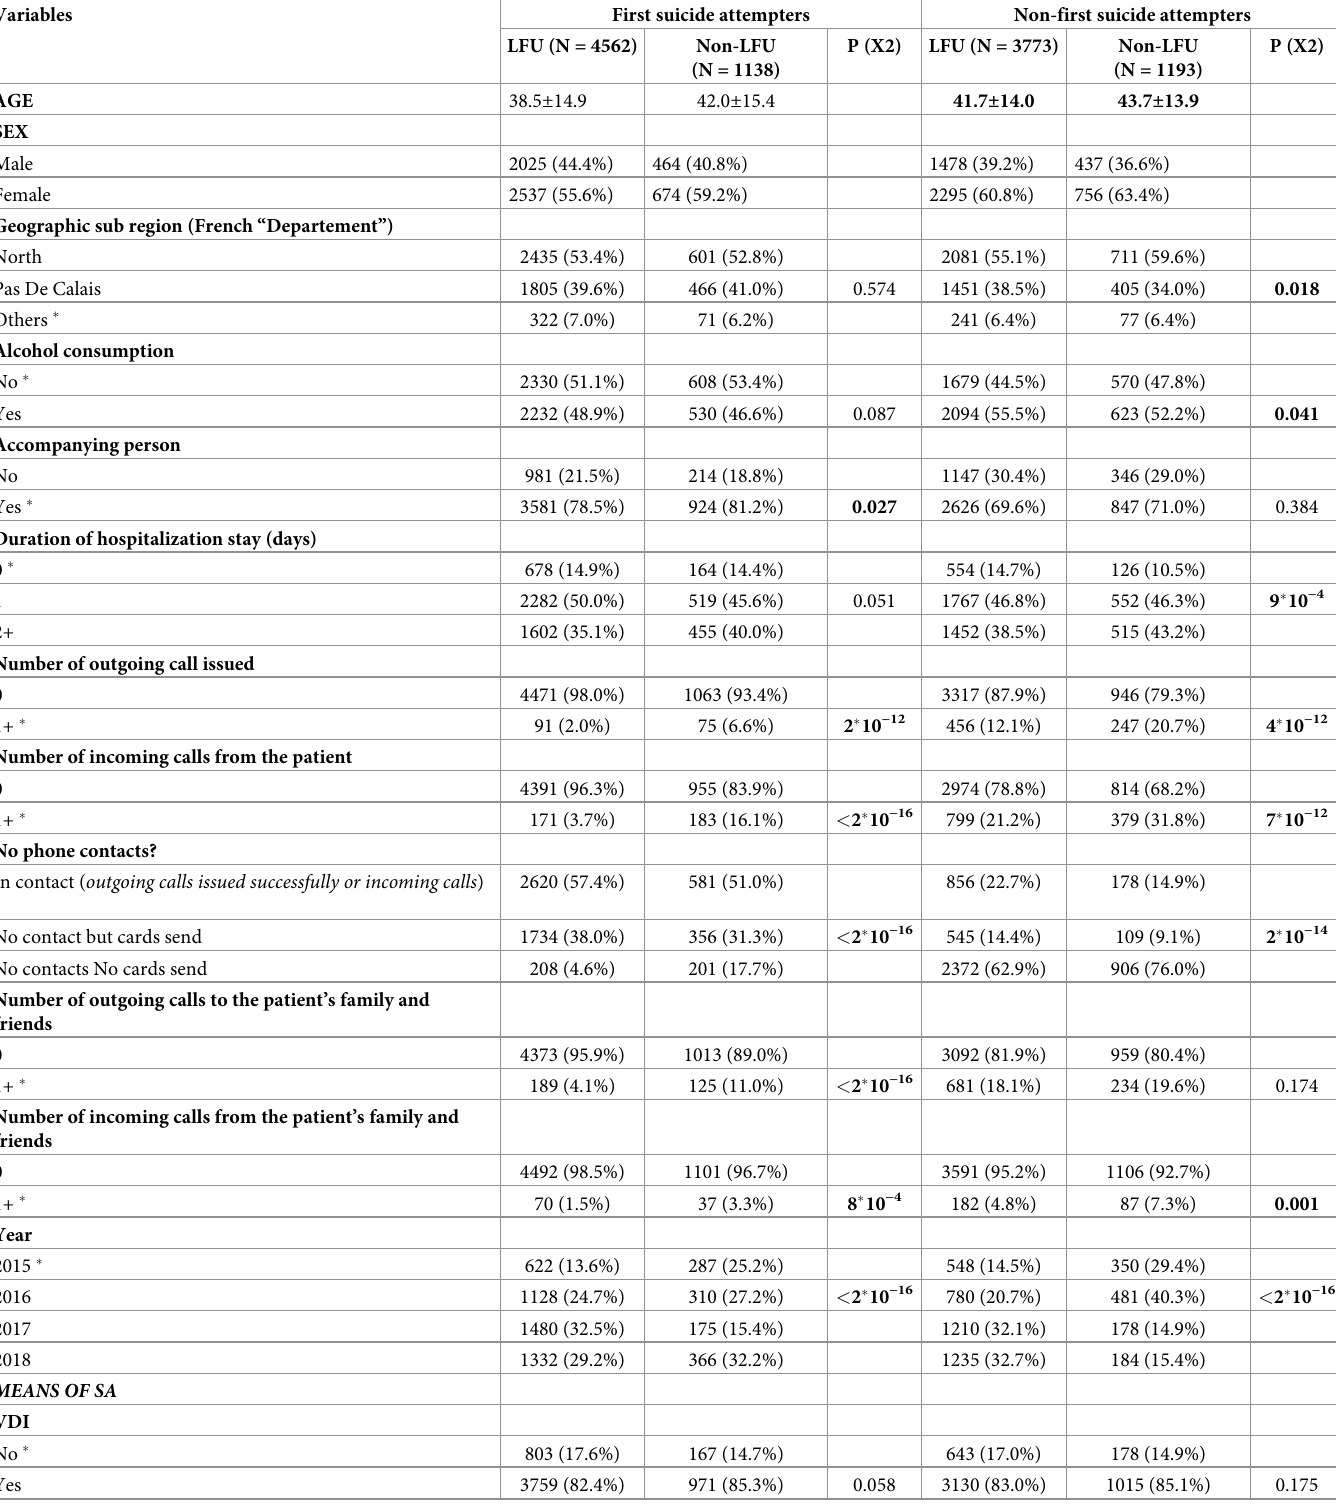
Table 3. Comparison of general characteristics of lost to follow-up and non-lost to follow-up patients and simple age and sex-adjusted logistic